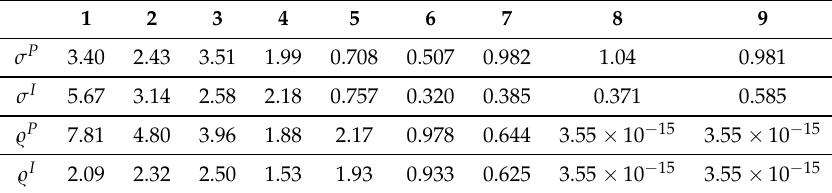
Table 7. Variance assumption parameters. (Observe that the (cid:36) P , (cid:36) I parameters become zero for development steps 8 and 9).